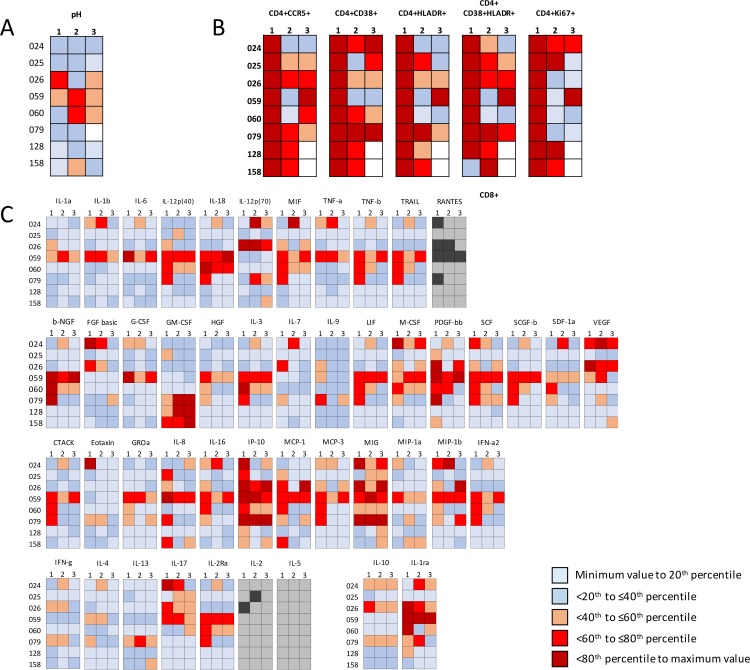
Longitudinal variation in genital pH, cytokine levels, and cervical cellular activation for AGYW who were persistently reproductively healthy over the three study visits.The percentile ranges were generated using the baseline values for the whole WISH cohort (n = 298). Blank squares represent missing data. RANTES, IL-2 and IL-5 are shown in grey as their concentrations were binarised as present (dark grey) or absent (light grey).